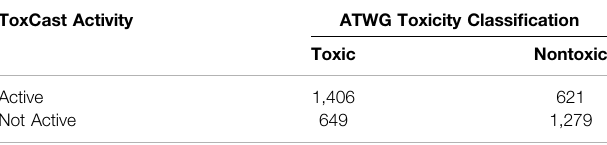
TABLE 3 | Comparison of ToxCast activity and acute oral toxicitySigni fi cance based on Fisher ’ s Exact Test: p -value = 2.2 × 10 − 16 , odds ratio = 4.46. Nontoxic chemicals are de fi ned as LD50 > 2,000